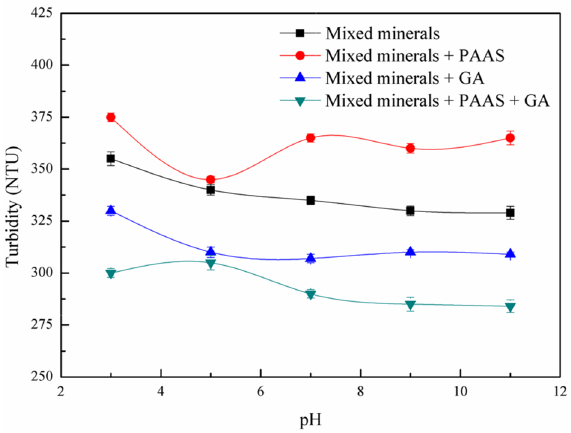
Figure 15. Relationship between dispersion of regulators on mixed minerals and pH (serpentine: talc = 1:1, mass ratio).